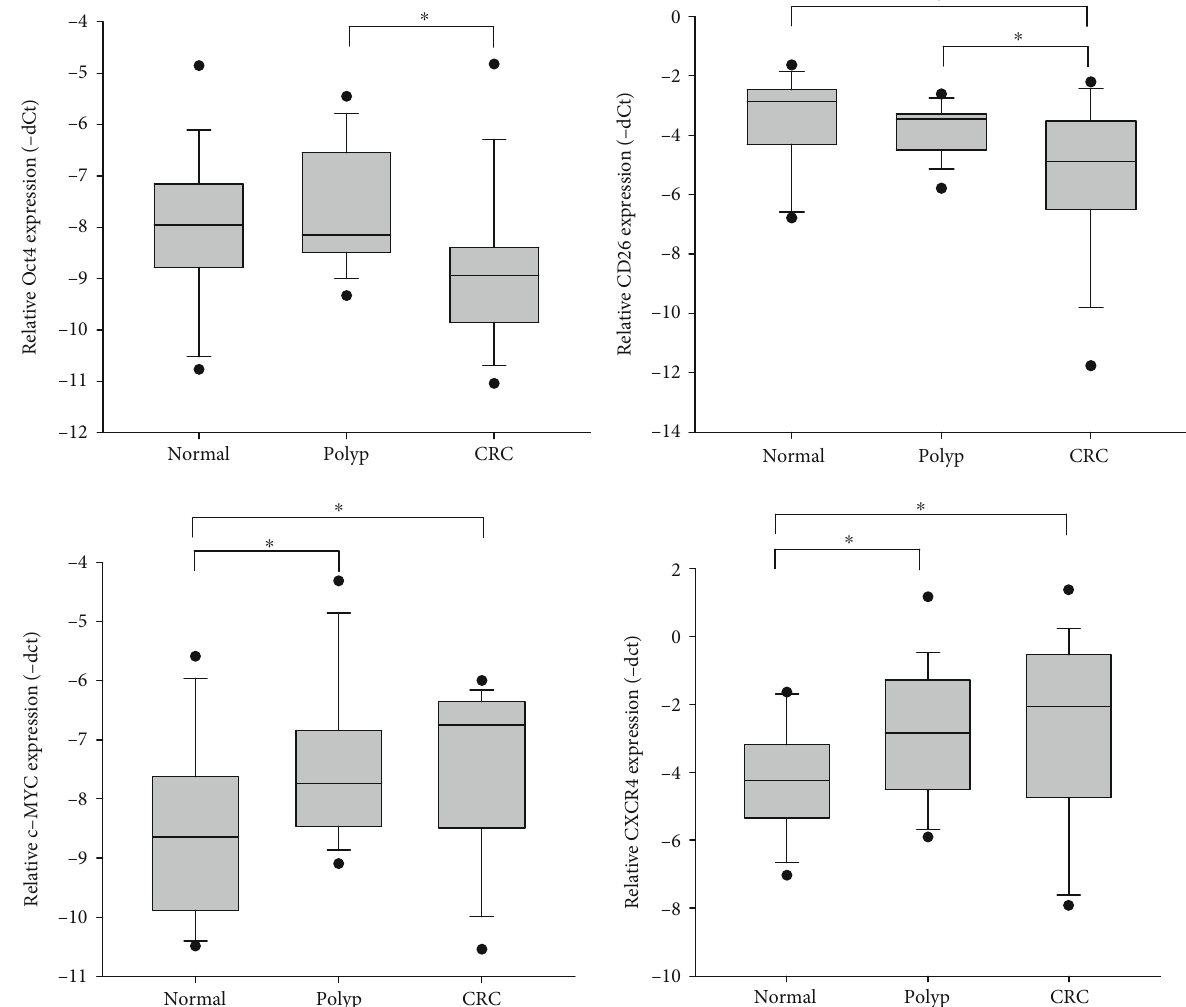
Polyp CRC Normal Polyp